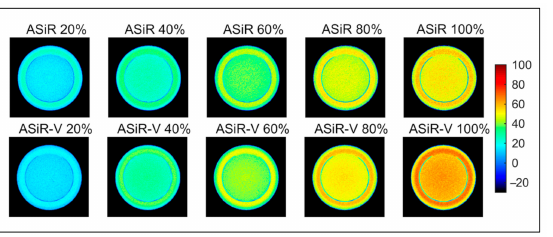
Figure 3. CTP486 phantom module. Maps of the percentage difference (%) between noise of the FBP-reconstructed CT image and noise of both ASiR-V-reconstructed and ASiR-reconstructed CT images with different blending levels (20%, 40%, 60%, 80%, and 100%).